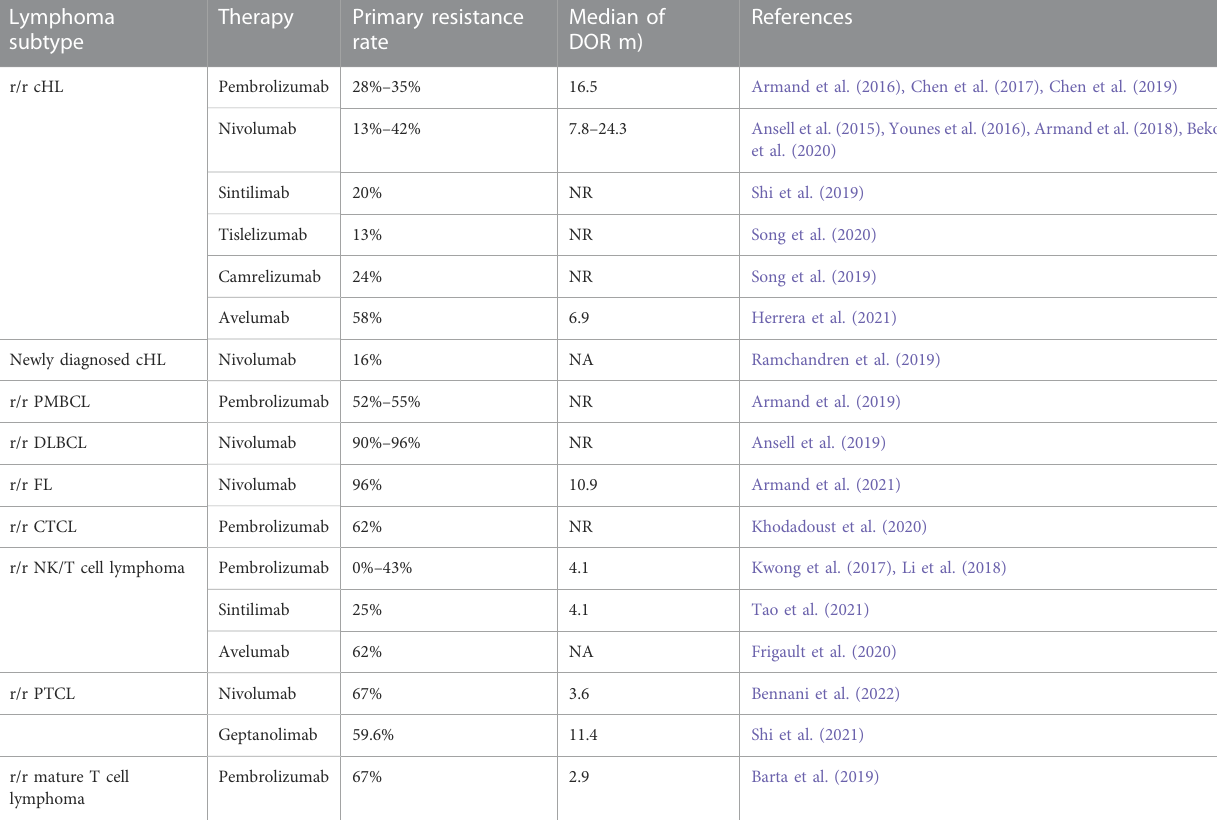
TABLE 1 The primary resistance rates and the medians of DOR of ICIs in lymphoma. Lymphoma